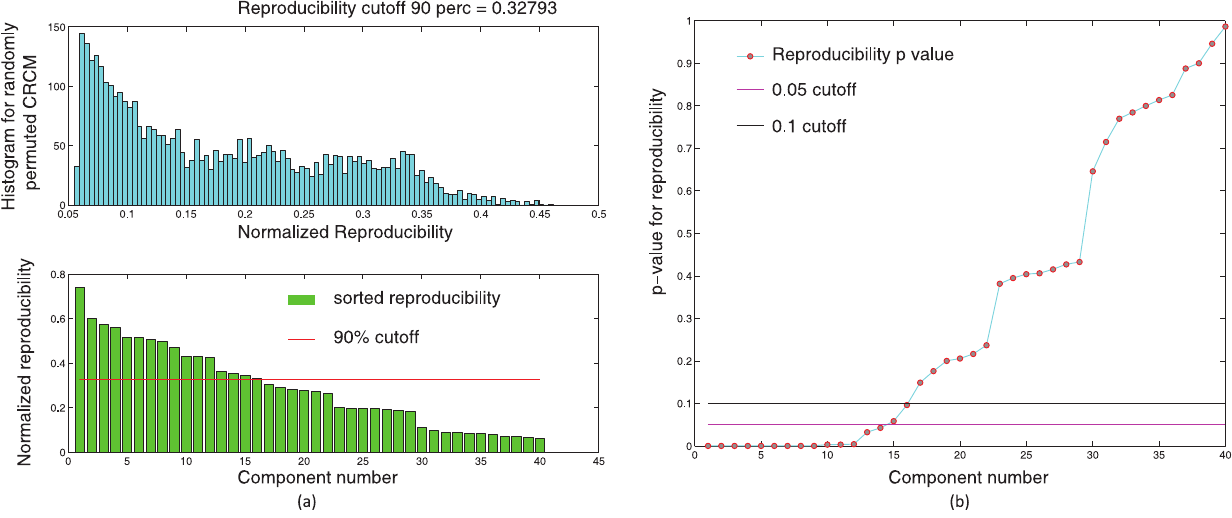
Figure 12. L ~ 5 subjects were randomly drawn from the set of N ~ 23 subjects and submitted to a temporal concatenation based group ICA. This process was repeated K ~ 100 times and the resulting ICA maps were submitted to a RAICAR-N analysis. Figure (a) shows the observed values of normalized reproducibility (bottom) as well as the ‘‘null’’ distribution of normalized reproducibility across R ~ 100 simulations (top). Figure (b) shows the p -values for each IC along with the 0 : 05 and 0 : 1 cutoff lines.